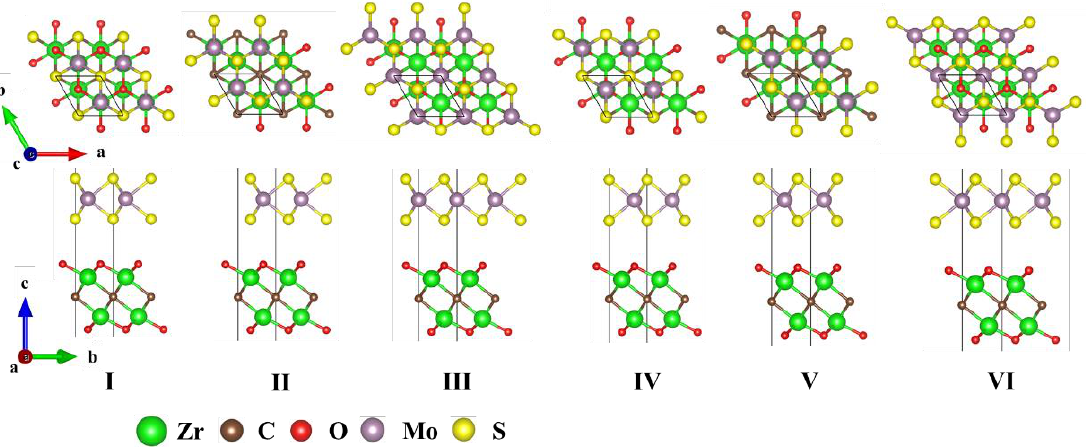
Figure 1. Schematic views of the Zr 2 CO 2 /MoS 2 heterostructures stacked by varying the position of MoS 2 layers. The upper layer and the lower layer represent MoS 2 and Zr 2 CO 2 , respectively. I to VI correspond to the six configurations.